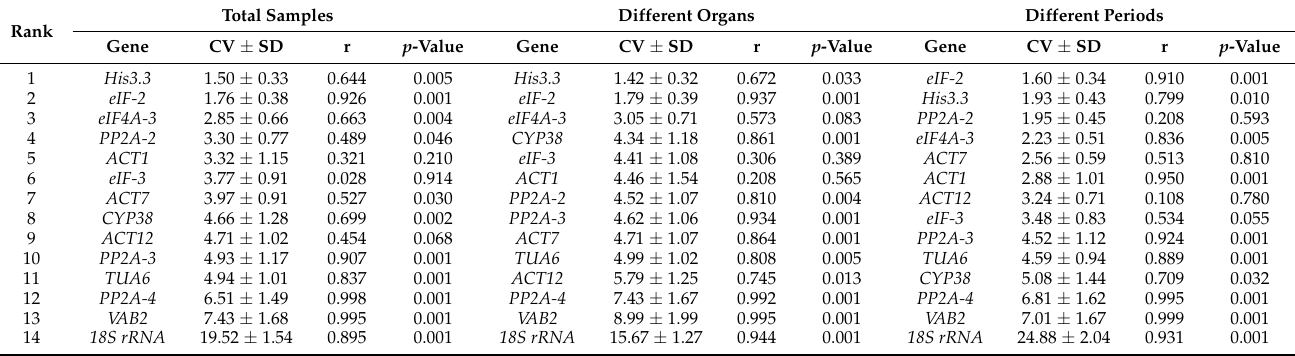
Table 2. Stability analysis of 14 candidate reference genes based on BestKeeper software.